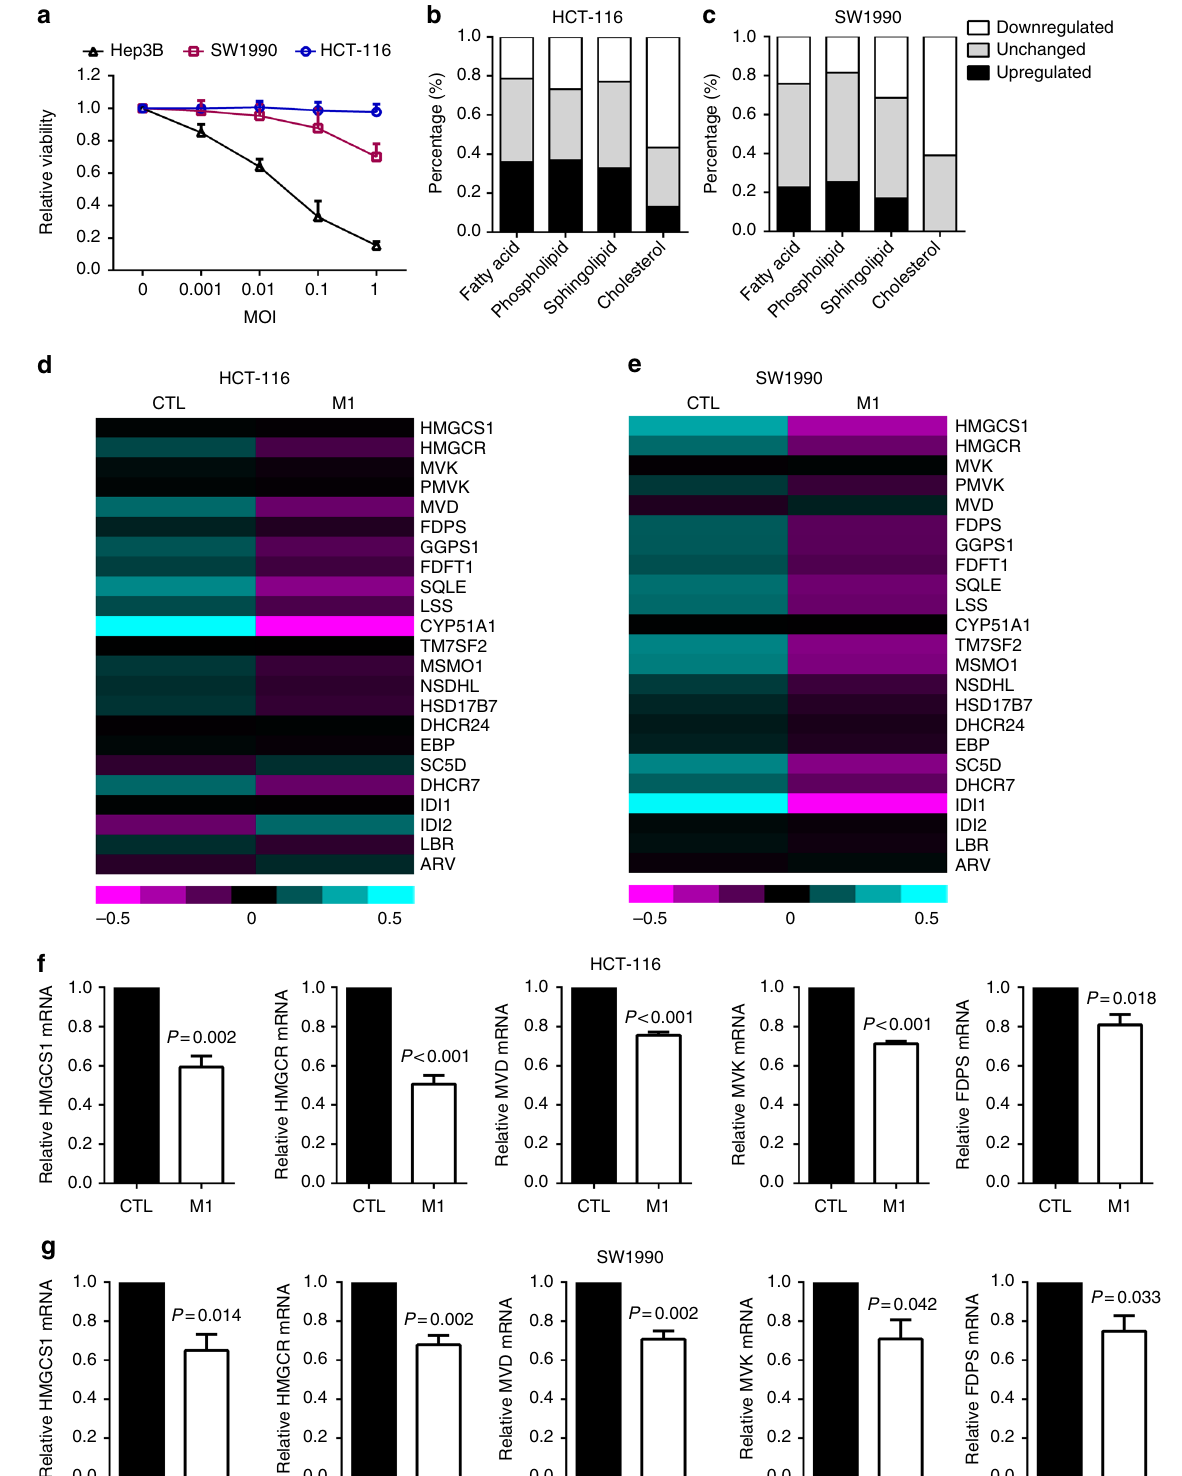
Fig. 1 Mevalonate – cholesterol synthesis pathway is downregulated after M1 virus infection. a HCT-116, SW1990, and Hep3B cells were infected with M1 virus (MOI = 0, 0.001, 0.01, 0.1, 1), and cell viability was determined with MTT assay 72 h after M1 virus infection. n = 3. Data shown in a , f , g were the mean ± SEM. b , c Analyzation of four kinds of lipid-related gene expression changes according to microarray data. HCT-116 and SW1990 cells were treated with M1 virus (MOI = 1) or vehicle. 24 h later, RNA was collected and analyzed by GeneChip Human Genome U133 Plus 2.0 Array (Affymetrix). Microarray analysis was performed on one sample. d , e Shown is heat maps of the mevalonate-cholesterol pathway related genes expression after M1 virus infection, according to microarray data above. f , g qRT-PCR detection of mevalonate-cholesterol pathway-related gene expressions after M1 virus infection (MOI = 1) for 24 h in HCT-116 and SW1990. n = 3. Statistical signi fi cance was using t -test,